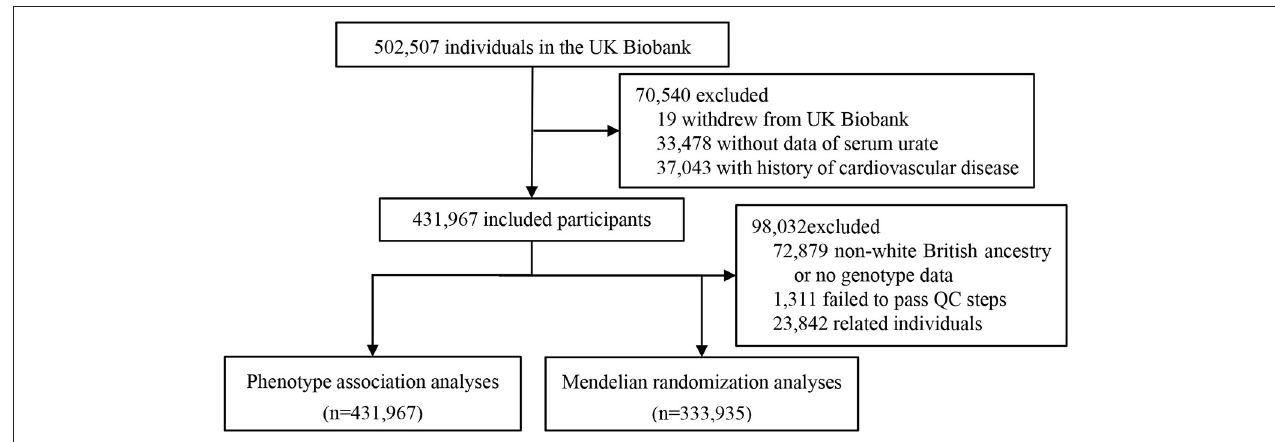
FIGURE 1 | Flow chart for study population